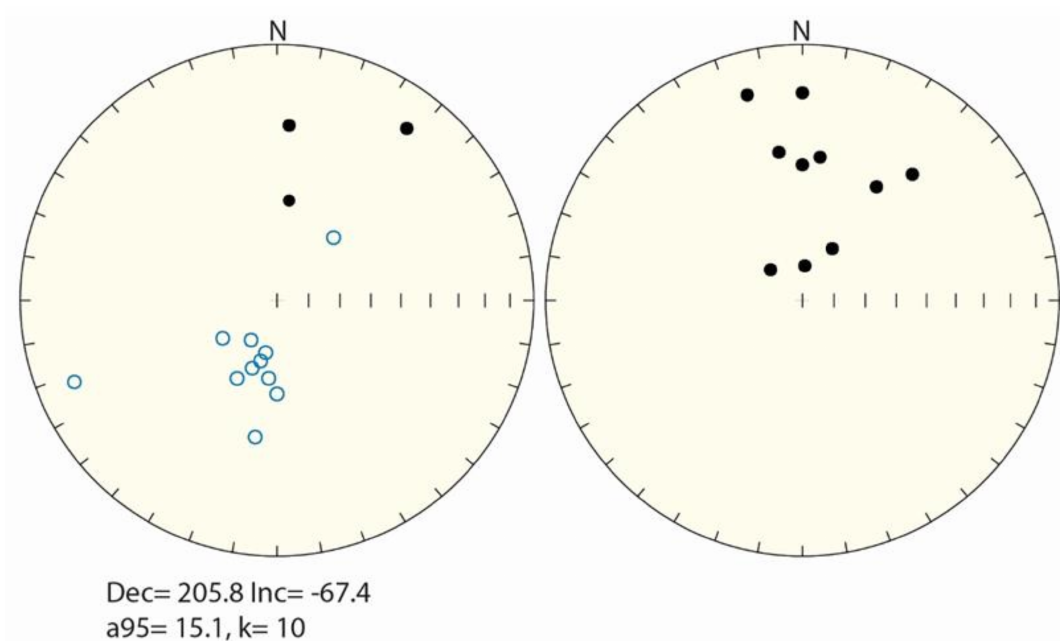
Figure 8. Lower hemisphere stereographic projection of paleomagnetic directions of site MI04. Stereonet on left shows characteristic remanent magnetization (ChRM) direction, high coercivity components. Stereonet on right shows viscous, low coercivity component. Open (closed) symbols represent vectors projected onto upper (lower)